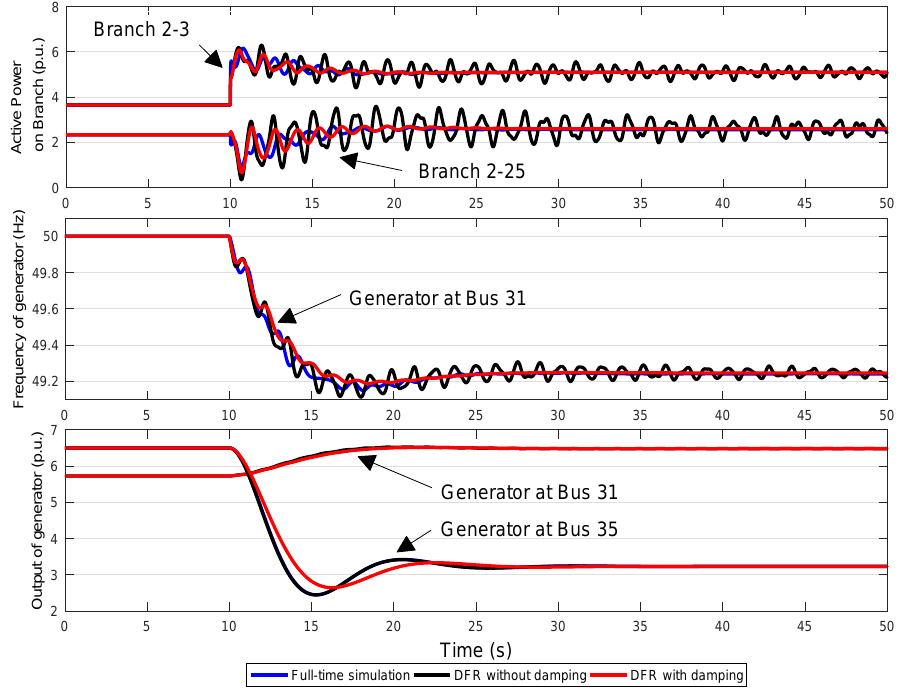
Figure 5. Dynamics of generator output, frequency and branch power flow after initial outages of branch 16–21 and branch 23–24 at t = 10.0 s in the IEEE 39-bus